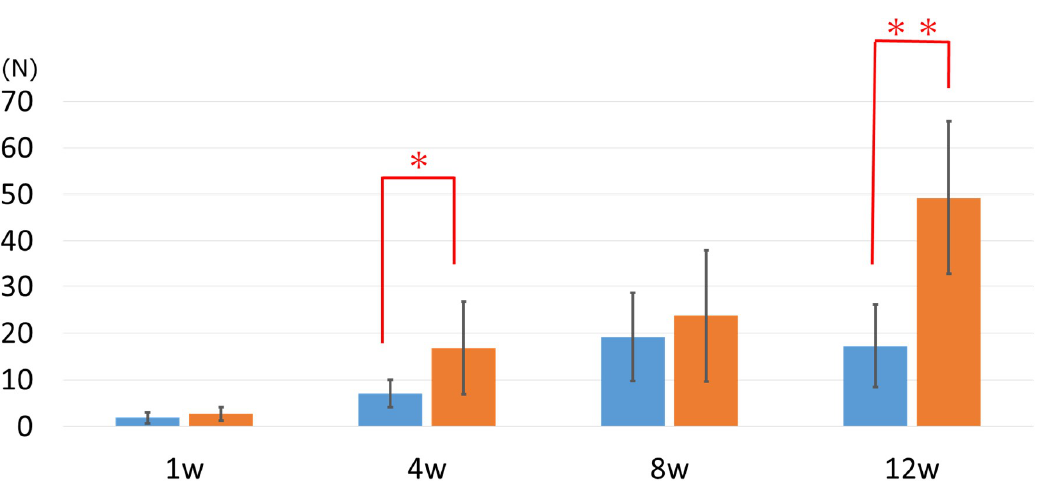
Figure 4. Evaluation of bone bonding. The mixed-acid and heat (MAH)-treated group shows significant increases in bone bonding at 4 and 12 weeks after implantation: 16.87 ± 9.90 N and 7.07 ± 2.91 N for the MAH group and the untreatedgroup, respectively, at 4 weeks, and 49.31 ± 16.58 N and 17.32 ± 8.86 N for the MAH group and the UN group, respectively, at 12 weeks. * <0.05, ** <0.01.